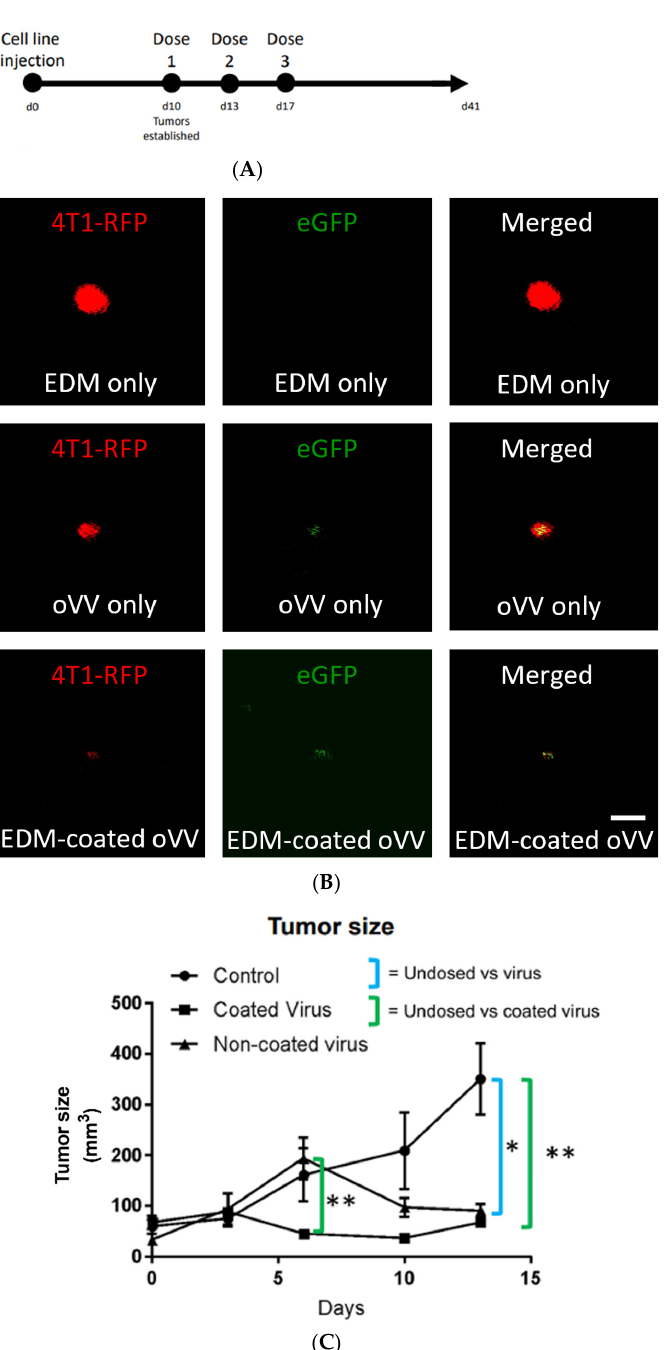
(Figure 7A). This places the virus directly into the target, circumventing the differences between the tumor accumulation of the bare and coated oncolytic virus.